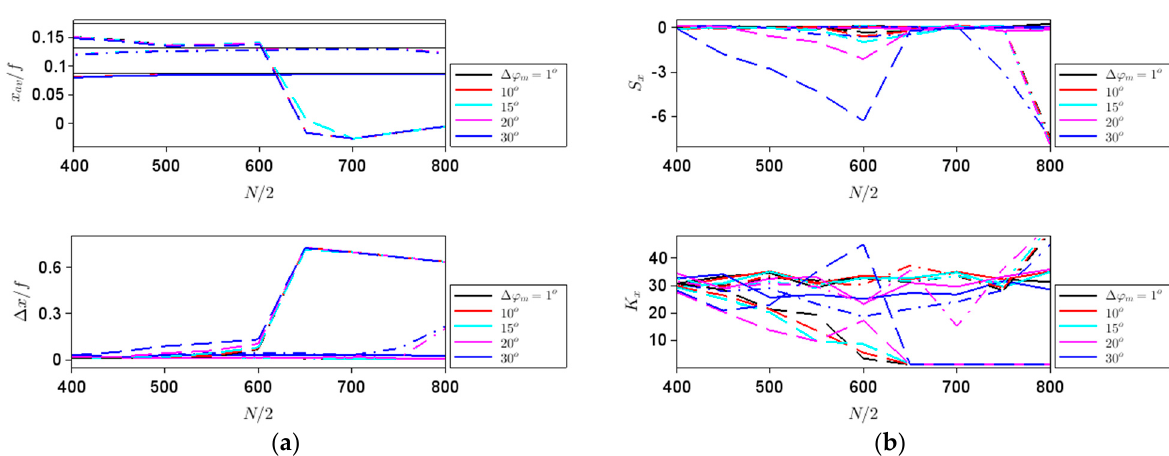
Figure 7. Dependence on the aperture size of ( a ) the transverse average position and spatial extent of the focalized beam and ( b ) of S x and K x for different phase steps indicated in the legend and for θ = 5° (solid line), 7.5° (dashed–dotted line) and 10° (dashed line).